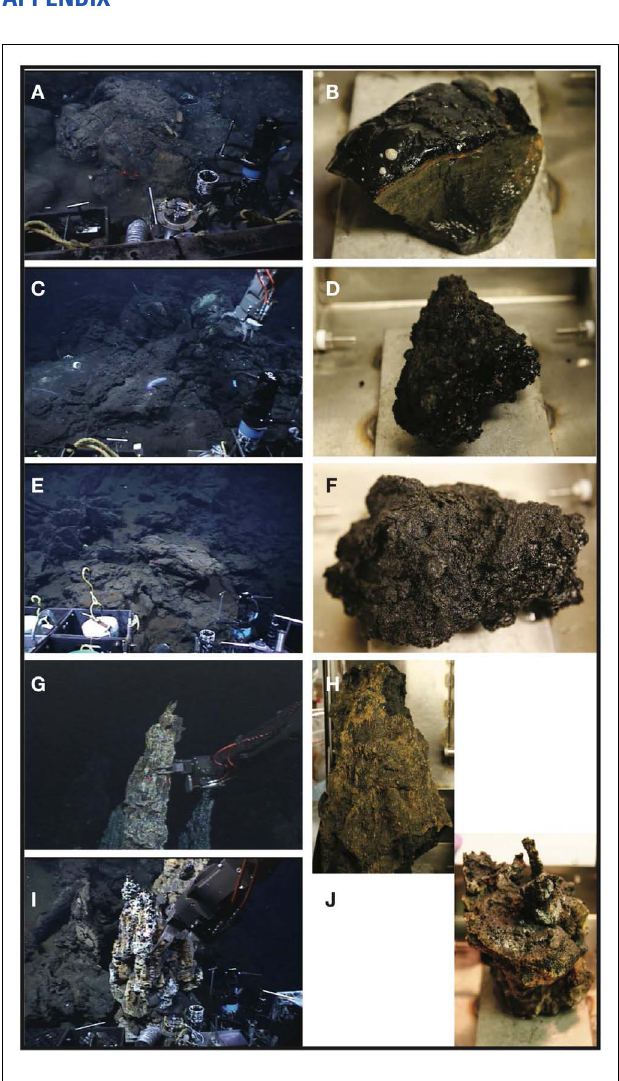
FIGUREA1 | Seafloor and shipboard photographs of samples collected during this study. Sample KiMba as it appeared on the seafloor (A) and in the sampling box (B) . Sample ABEba on the seafloor (C) and onboard (D) . Sample Marba as it appeared on the seafloor (E) and on the ship (F) . Sample ABEs as it was collected by ROV Jason II (G) and on the ship (H) . SampleTuiMs, photographed during collection (I) and on the ship (J) .